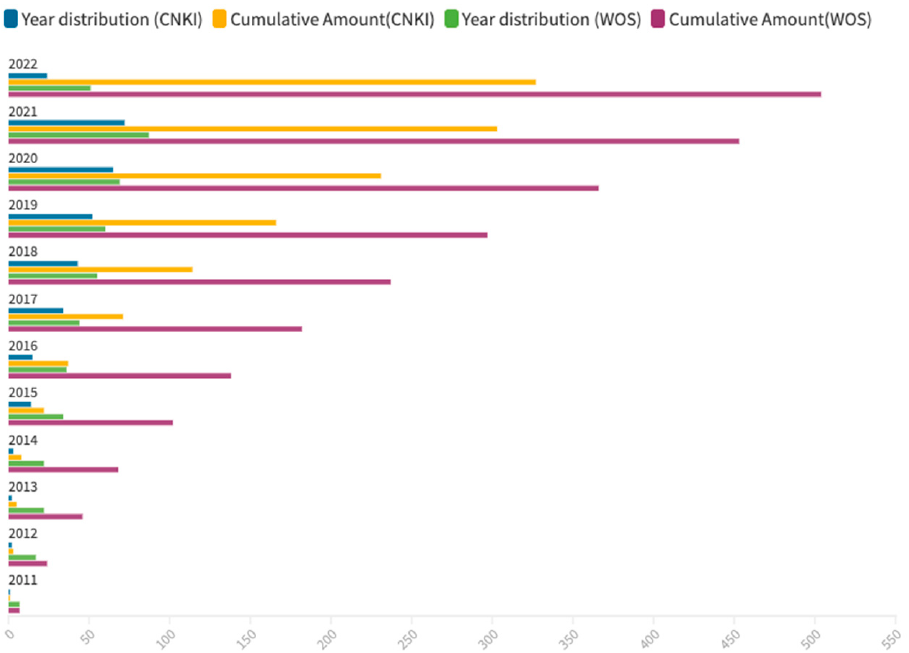
Figure 2. Publication distribution of CNKI (retrieved on 17 July 2022) and WOS (retrieved on 19 July 2022).